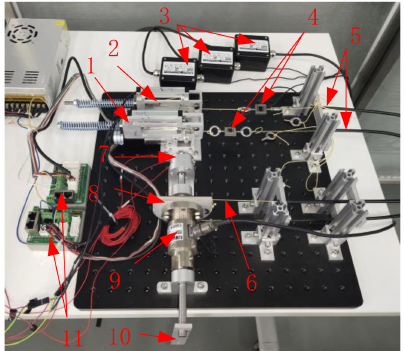
Figure 11. Schematic diagram of experimental platform. 1, extension side cable SEA; 2, flexion side cable SEA; 3, signal converter of tension sensor; 4, tension sensor; 5, cable sheath; 6, cable at drive end; 7, angle sensor; 8, rotating disk; 9, torque sensor; 10, load arm; 11, motor driver.